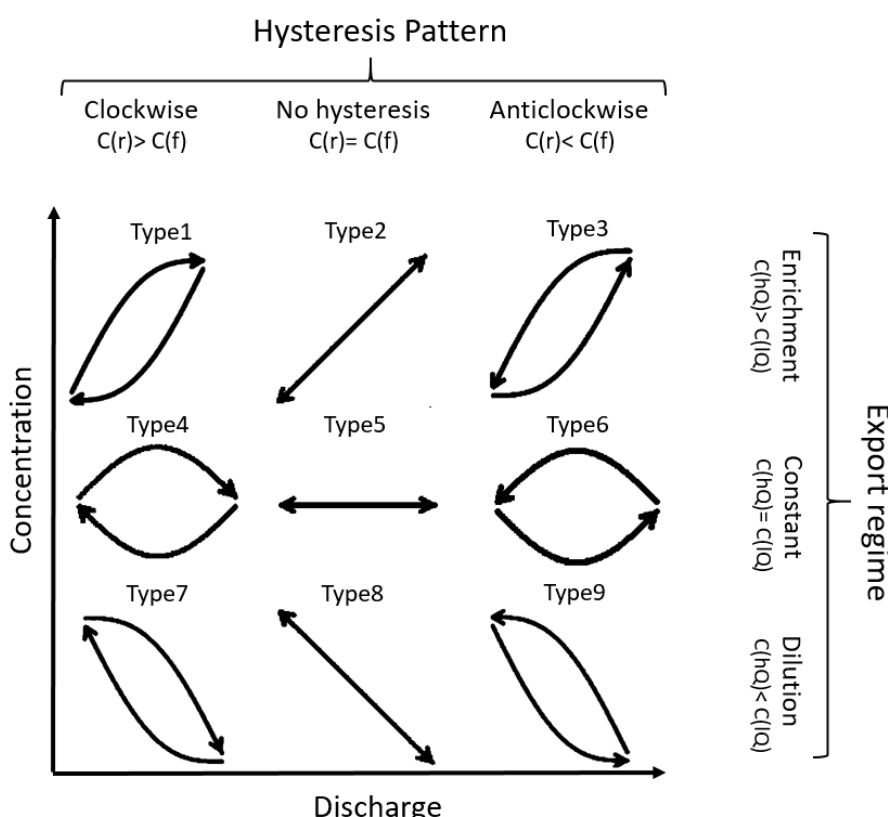
Figure 2. Schematic of the concentration–discharge (C-Q) classification considering both export regime and hysteresis pattern resulting in 9 types of C-Q relationships. Hysteresis patterns include: clockwise (concentration (C) at the rising limb (r) is higher than at the falling limb (f)), no hysteresis (no difference in concentrations at the rising and falling limbs), and anticlockwise (concentration at the falling limb is higher than at the rising limb). Export regime includes: enrichment (concentration increases with discharge) and constant (concentration does not change with discharge) and dilution (concentration decreases with discharge—lower C at high (hQ) than at low discharge (lQ)). Modified from [35].